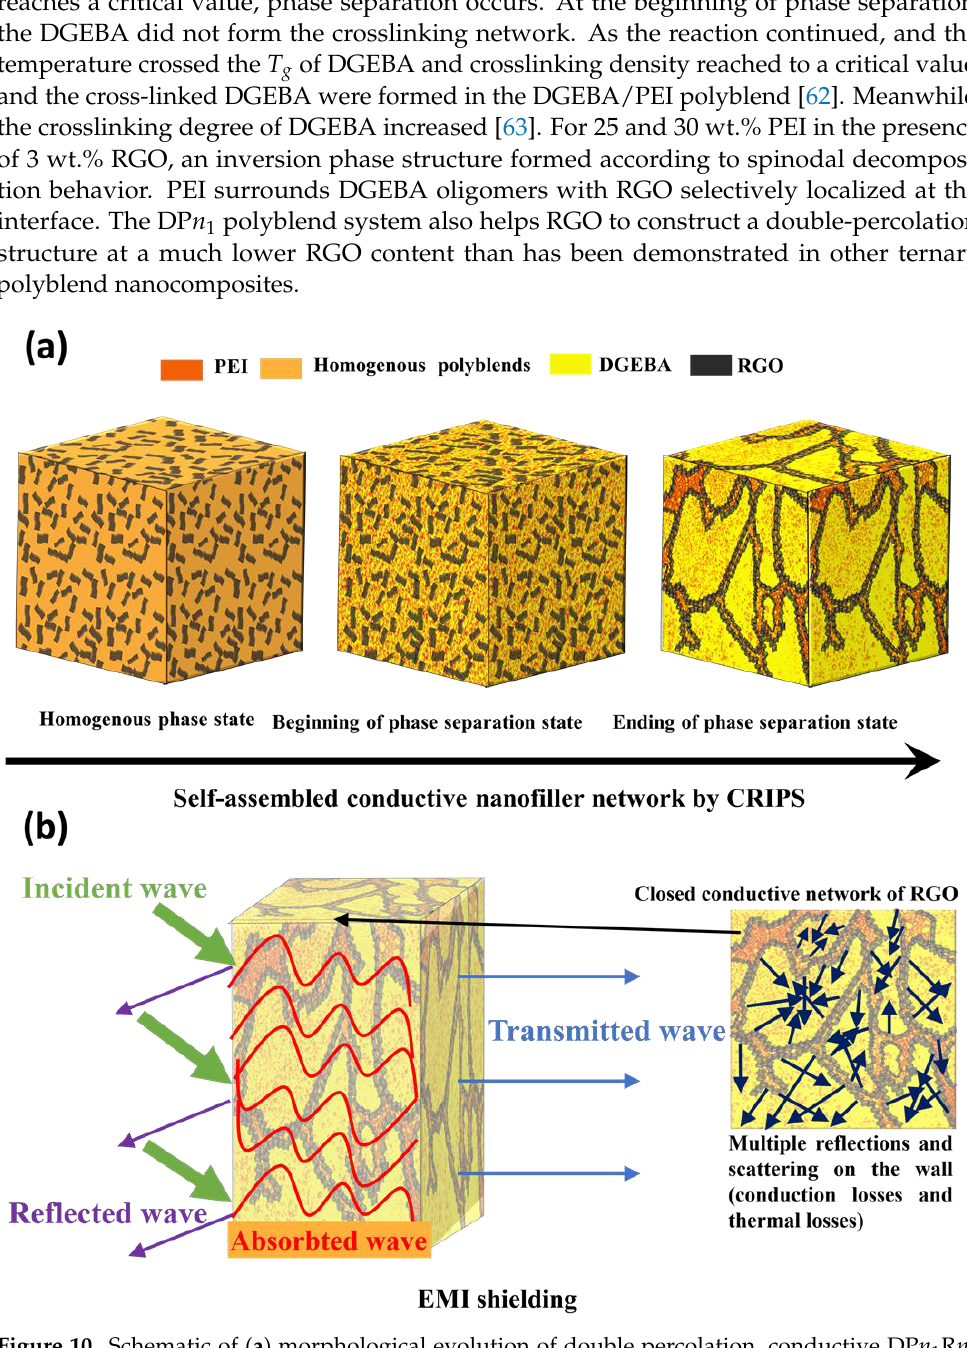
Figure 10. Schematic of ( a ) morphological evolution of double percolation, conductive DP n 1 R n 2 nanocomposites and ( b ) the EMI shielding mechanism of DP n 1 R n 2